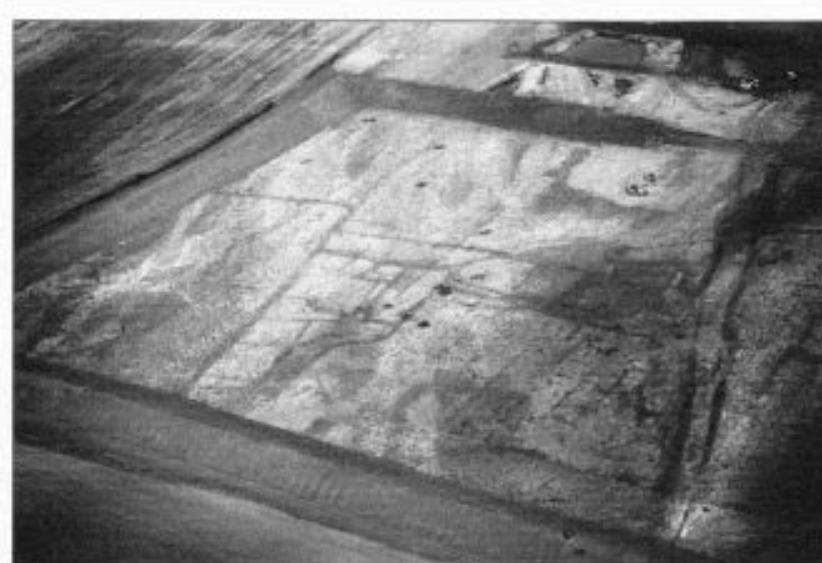
Figure 3 Aerial view of the field system at Lydd 1 , looking northeast, October 1 991. definite residential areas are adjacent to one or other of the two trackways. The lo­ cations of other sites (e.g. B in Lydd 1), where other activities took place, was not constrained in this way. Early twelfth-cen­ tury pottery was found during the excava­ tions, although none of the residential areas can be dated to that period. The start of intensive cultivation and consequent occupation occurred only towards the end of the twelfth century after an initial period of pastoralism on the newly reclaimed marginal land. Most of the residential areas date to the late twelfth to fourteenth cen­ turies, although not all were settled con­ temporaneously: the occupation shifted from site G to F in the fourteenth century, whereas sites C and G were apparently in use at the same general date. SiteD is prob­ ably another residential area, judging by the small size of the nearby enclosures, its position close to the line of one of the track­ ways, and the quantities of domestic refuse surrounding it. Ifthis is correct, then three sites (C, D, G) were occupied within the 18ha area during the thirteenth to early fourteenth centuries. Later settlements at Lydd are far